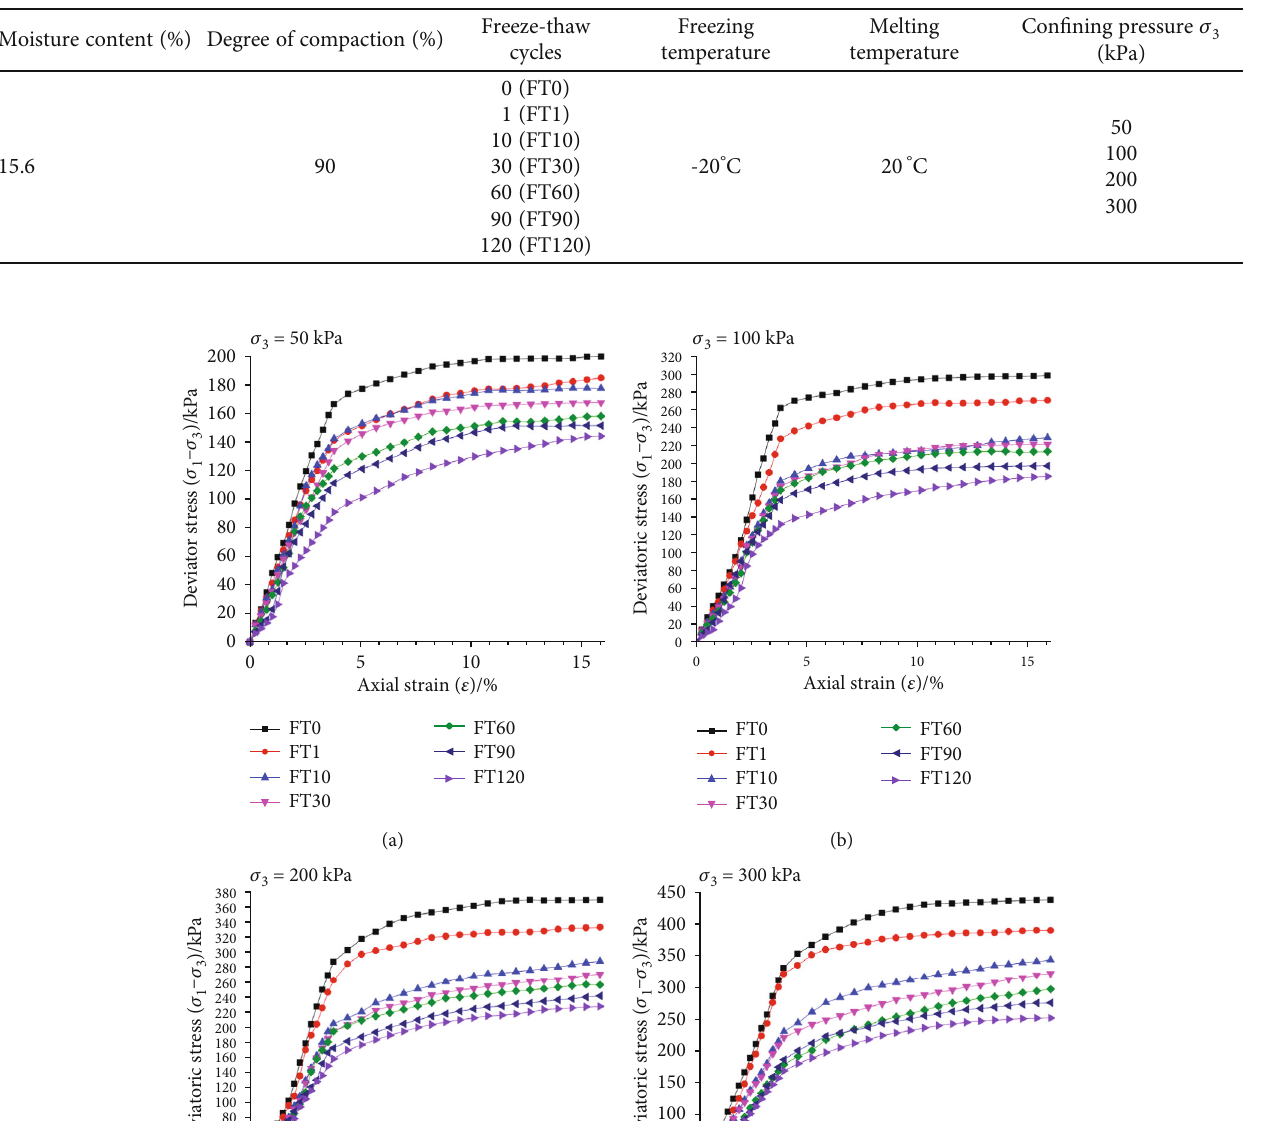
Table 3: Experimental scheme of the test.